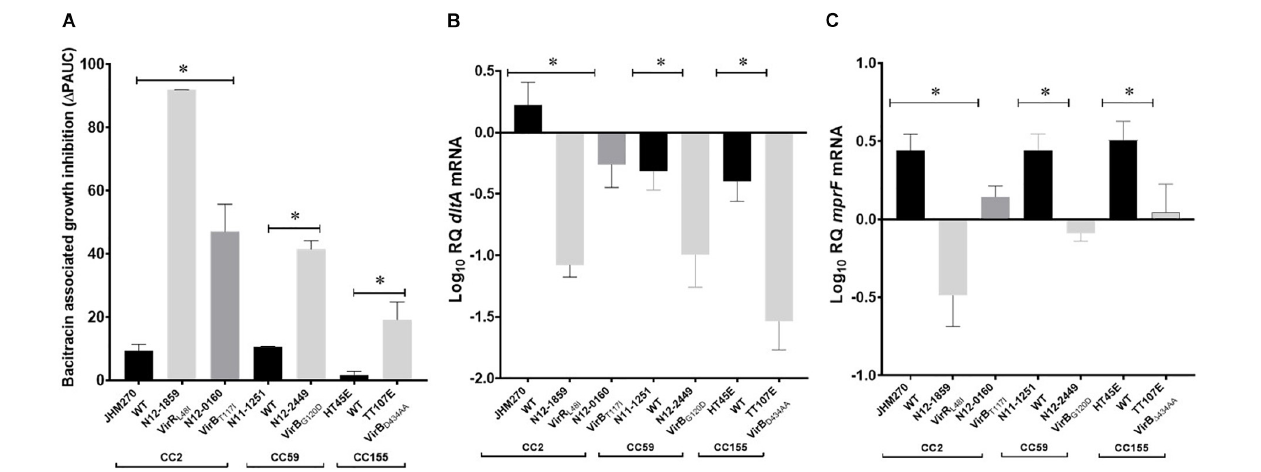
FIGURE 12 | Phenotypic evaluation of high nisin sensitivity L. monocytogenes field strains with natural vir operon mutations. (A) Bacitracin sensitivity comparison based on bacitracin induced growth inhibition ( (cid:49) PAUC) and quantification of VirR dependent dltA (B) and mprF (C) mRNAs in high nisin sensitivity vir operon mutant strains (N12-1859, N12-0160, N12-2449, and LK132) compared with corresponding clonal control strains (JHM270, N11-1251, and HT45E) without vir operon mutations. Data presented is based on three independent biological experiments. * P > 0.05 significant differences that were identified using one-way ANOVA and Tukey post hoc (groups with more than two strains) pairwise comparison of the strains.